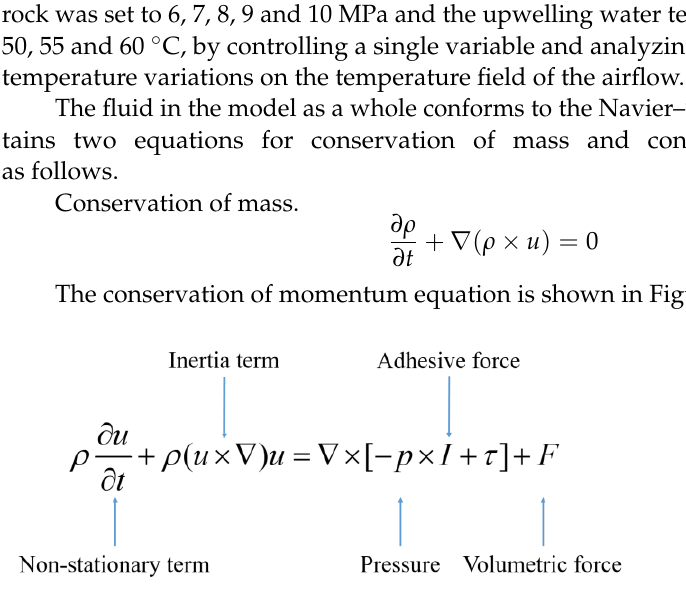
Figure 10. Conservation of momentum equation.